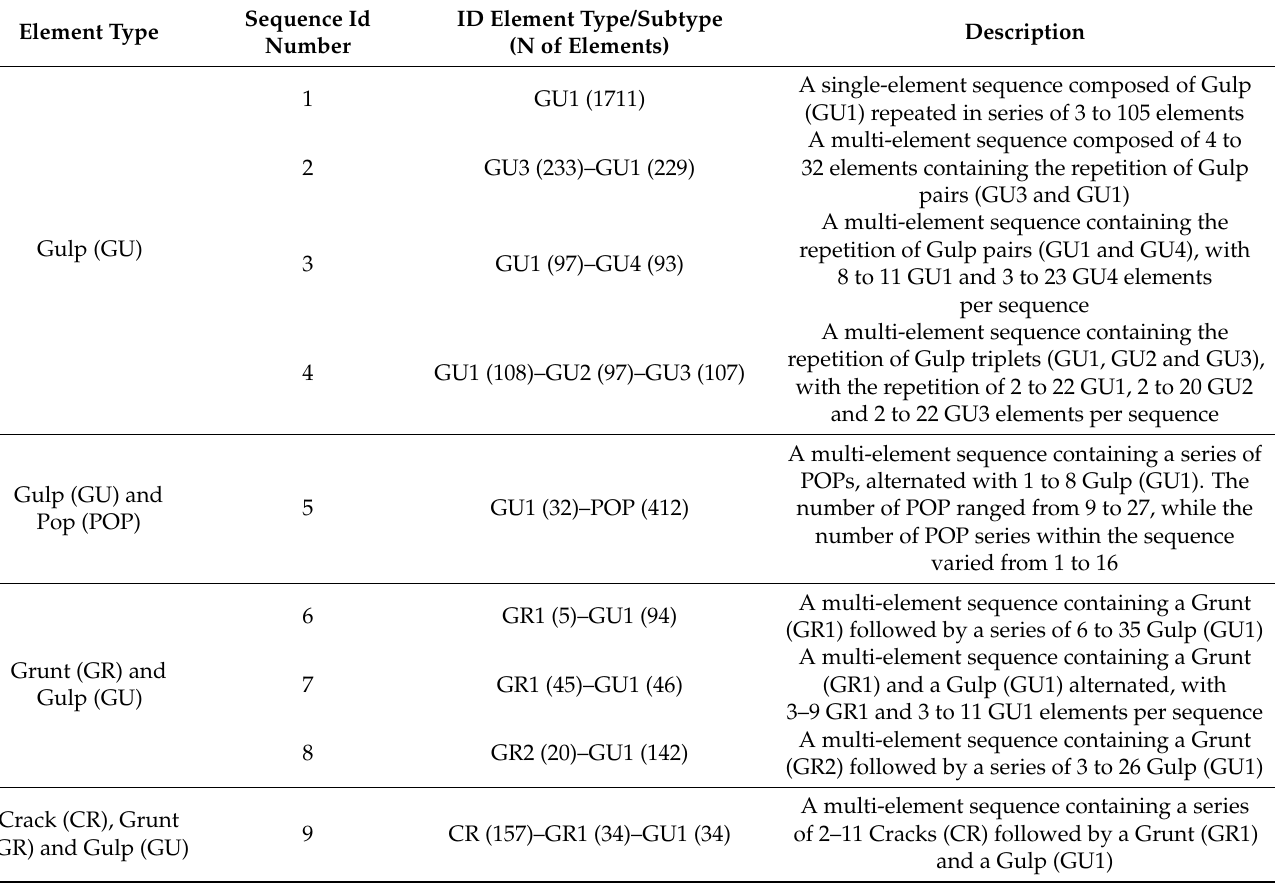
Table 3. Parameters measured for each bray call series and for each single element composing the